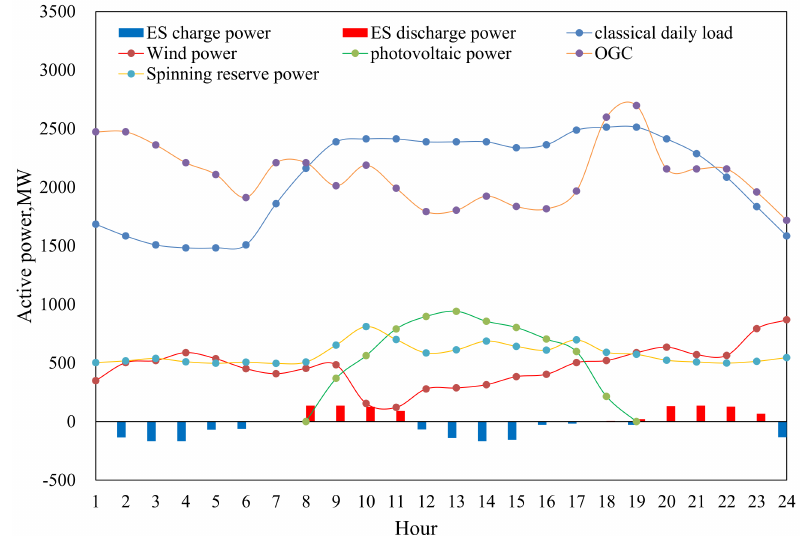
Figure 4. Status of source and load and